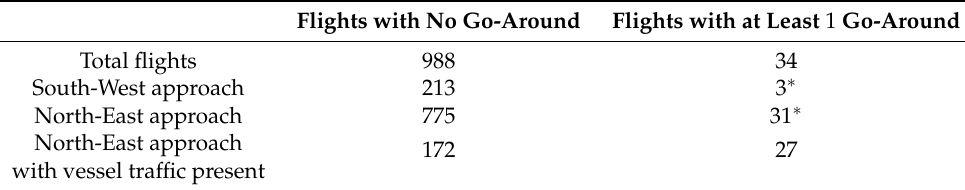
Table 2. Comparison of number of North-East and South-West approaches and vessel traffic for flights in 2019. Flights with No Go-Around Flights with at Least 1 Go-Around Total flights 988 34 South-West approach 213 3 ∗ North-East approach 775 31 ∗ 172 with vessel traffic present